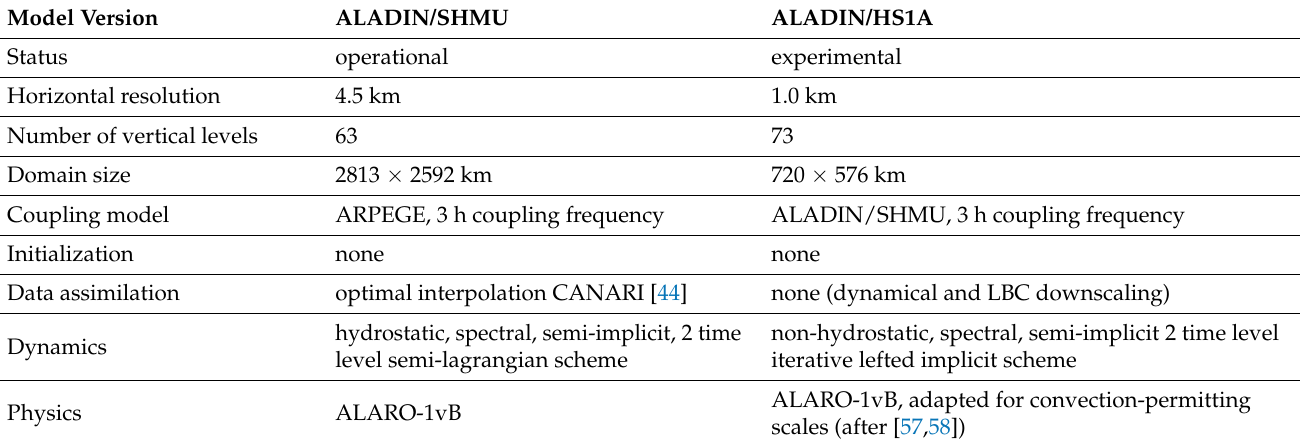
Table 3. Main characteristics of the ALADIN model configurations used for the wet snow case